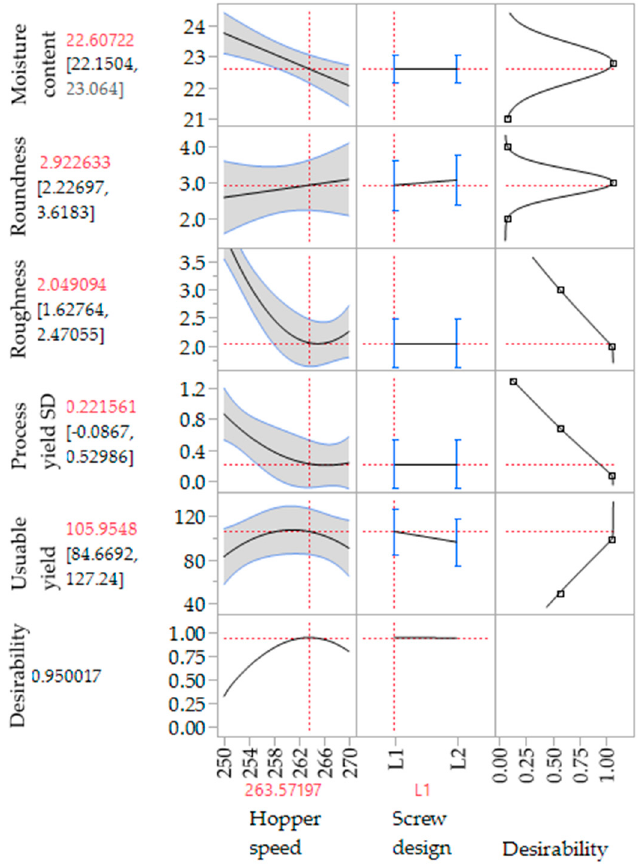
Figure 7. Proposed extrusion configurations for a maximized desirability of all responses (CQAs) measured (useable yield, process yield SD, roughness, roundness, moisture content).